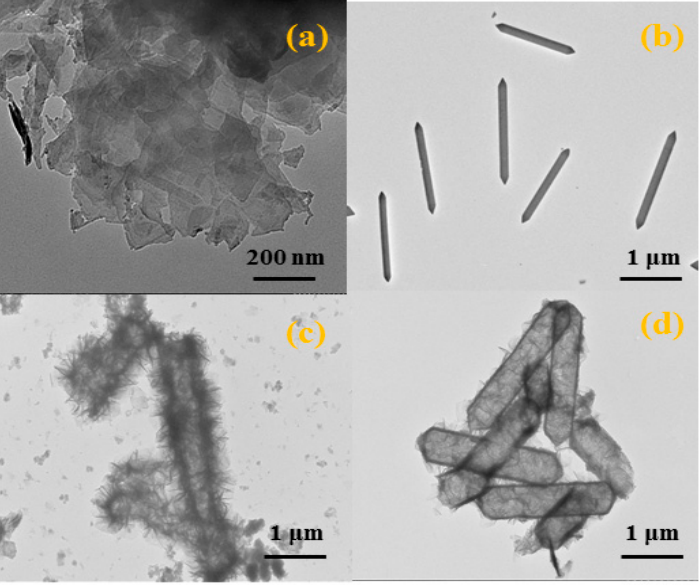
Figure 5. TEM images of MoS 2 ( a ), MIL-88A ( b ), NiFeCe-LDH ( c ), NiFeTb-LDH ( d ).